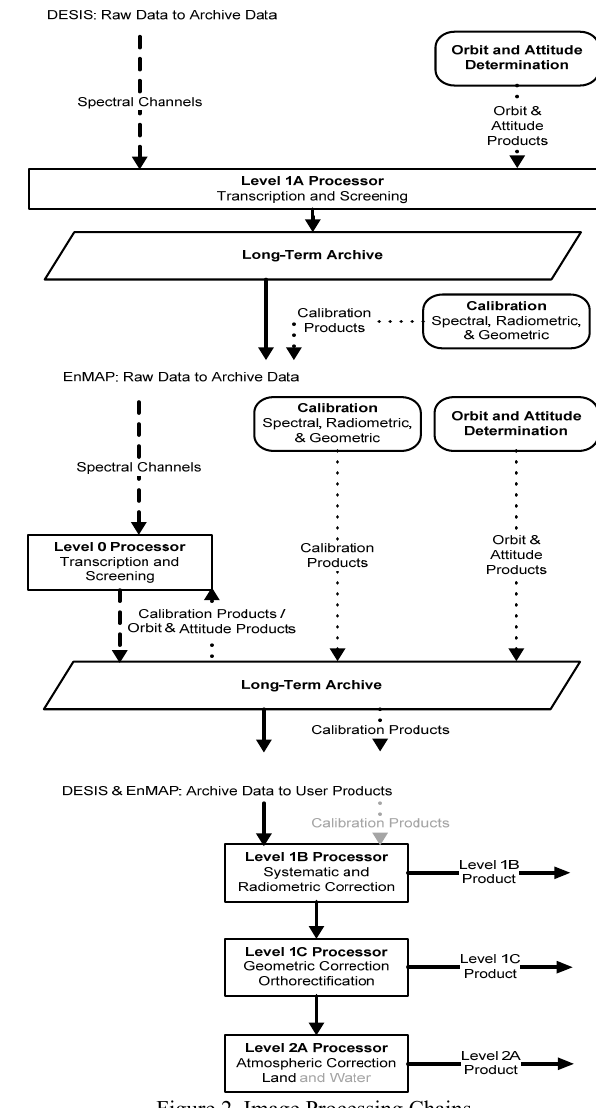
Figure 2. Image Processing